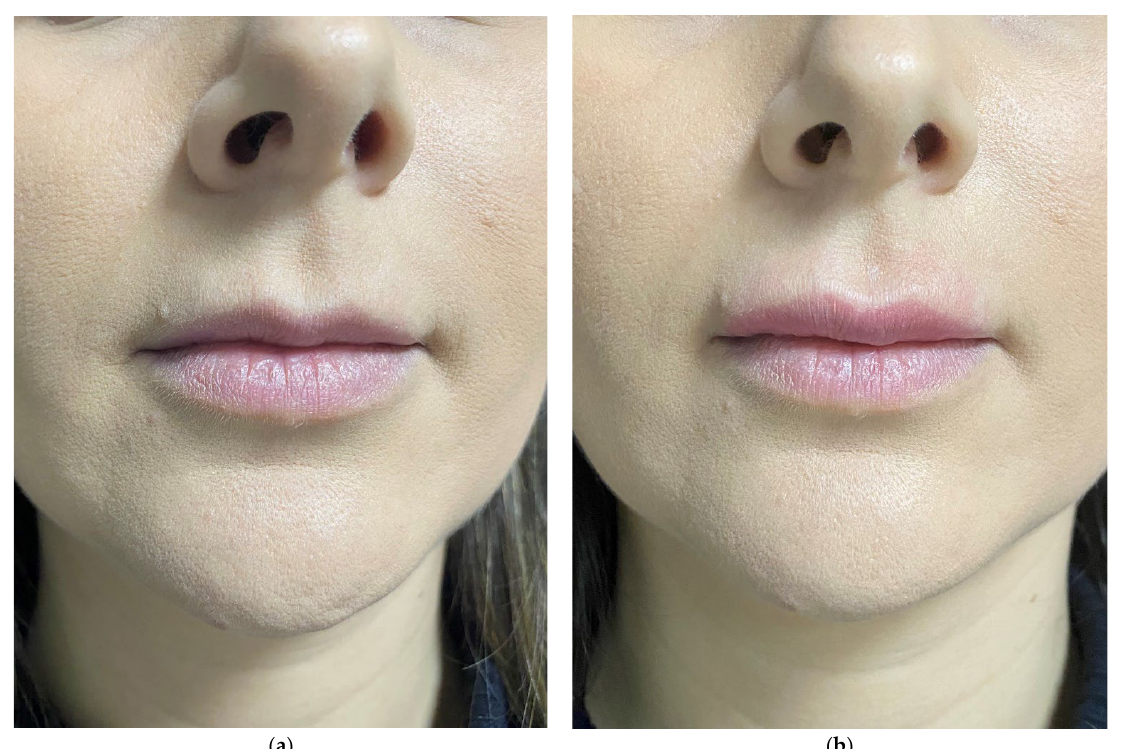
Figure 4. Asymmetric upper and lower lips after gnathosurgery with a flattened philtrum ( a ). Correction by injection of HAF in the upper lip (vermillion, philtrum, and cutaneous mucosa line) ( b ) . Edentulism is related to the aging process and presents the endpoint of dental disease. The world-wide prevalence for 2010 was estimated to be 2.3% [49]. The etiology is complex and depends on genetics, lifestyle, and comorbidities. Edentulism leads to significant alveolar bone resorption of up to 25% within its first year. In addition to this, the jawbone height becomes reduced, changing the profile of the face. The chin gets projected forward, and the lips appear thinner and crushed. Another consequence of edentulism is an ongoing atrophy of the orbicularis oculi muscle, leading the invagination of the red lips and accentuation of fine lines , the labiomental fold, and the labiomental crease [50,51 ]. In the concept of complex rehabilitation (bone, teeth, and gingiva), HAF may play an auxiliary role. HAF can be used to improve nasolabial folds, labial commissures, lip contour, and philtrum. This contributes to improved self-esteem and self- rated health [52]. Documentation of clinical effects is done by clinical investigation, subjective data from the patients, and standardized photography. 8. Reconstruction of Lost Interdental Papilla Gingiva and dental papilla play an important role in protecting and maintaining periodontal structure and health. They are also involved in phonetics. Loss of dental papilla is multifactorial. Known factors include colonization with Porphyromonas gingivalis , herpes, periodontitis, senescence, and oral exposure to metals and metalloids [53,54 ].